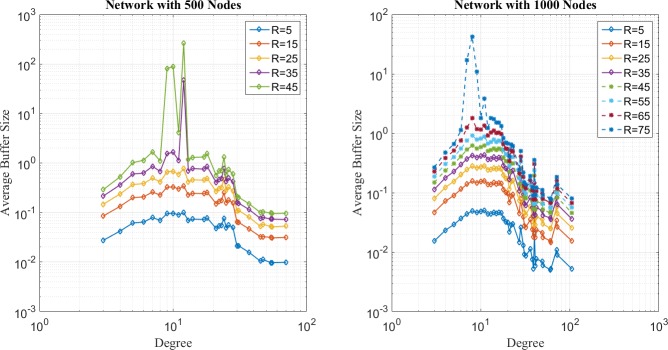
Relationship between average buffer size and node degree for EP on networks with 500 nodes (left figure) and 1000 nodes (right figure).